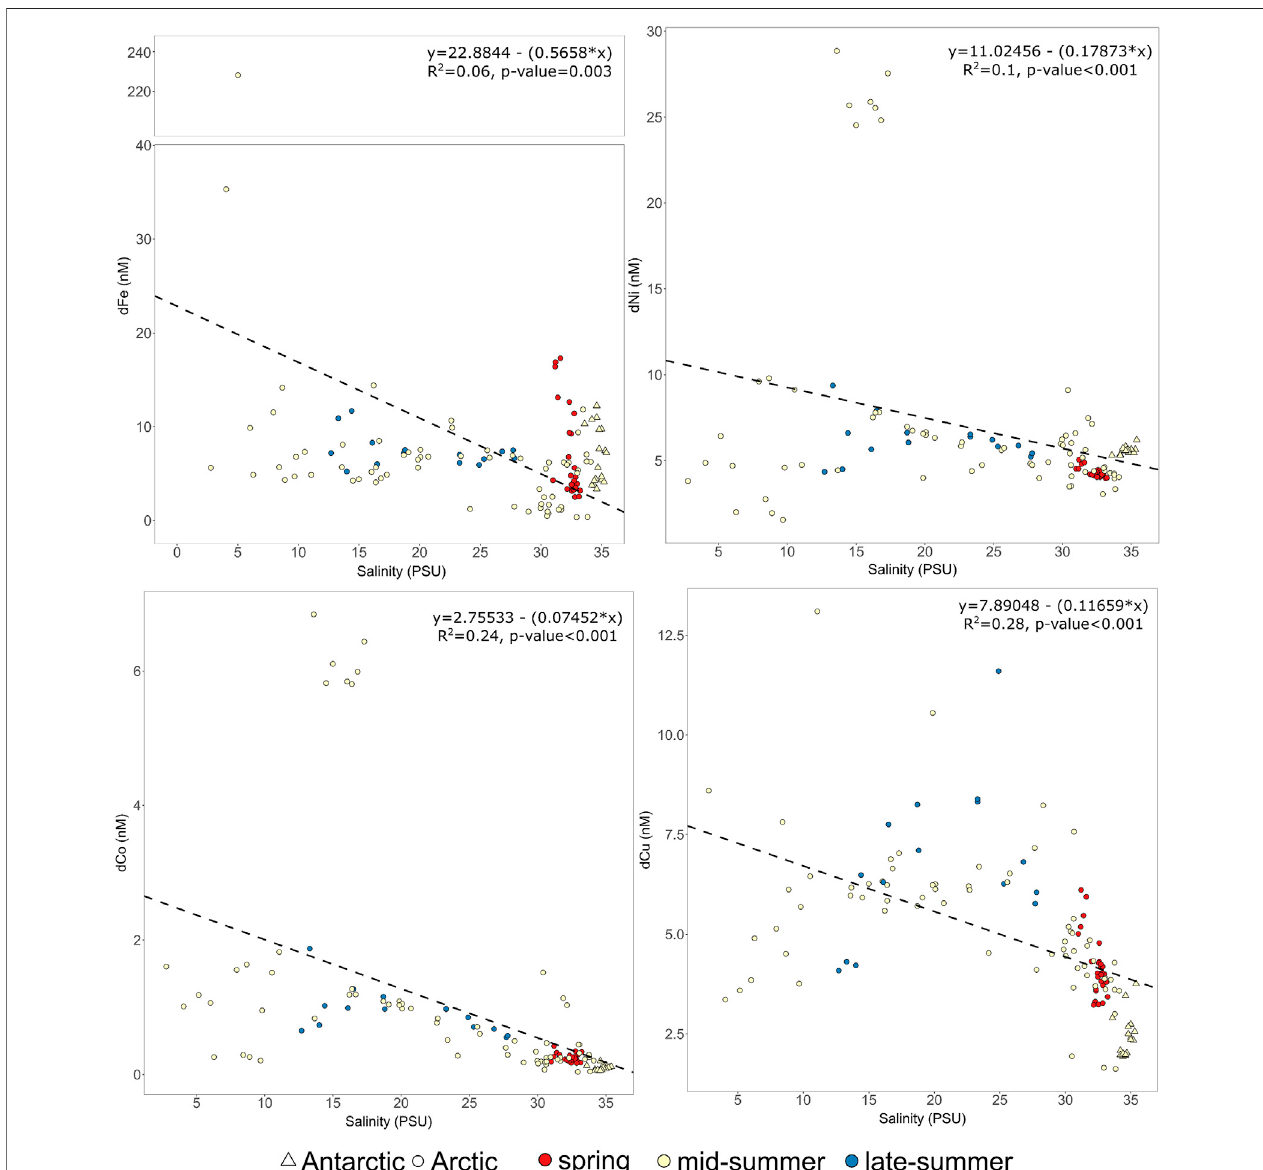
FIGURE2| ThedistributionofdCo,dCu,dNianddFe(allnM)acrossthesalinitygradientinallcatchments.AllArctic(circles)andAntarctic(triangles)dataisplotted withcolor denoting the seasonal timing (red, spring;yellow,mid-summer; blue, late-summer). The linearregressions refer toall data and were not improved (i.e., lower p value) by using only summertime data. Note the break in the dFe